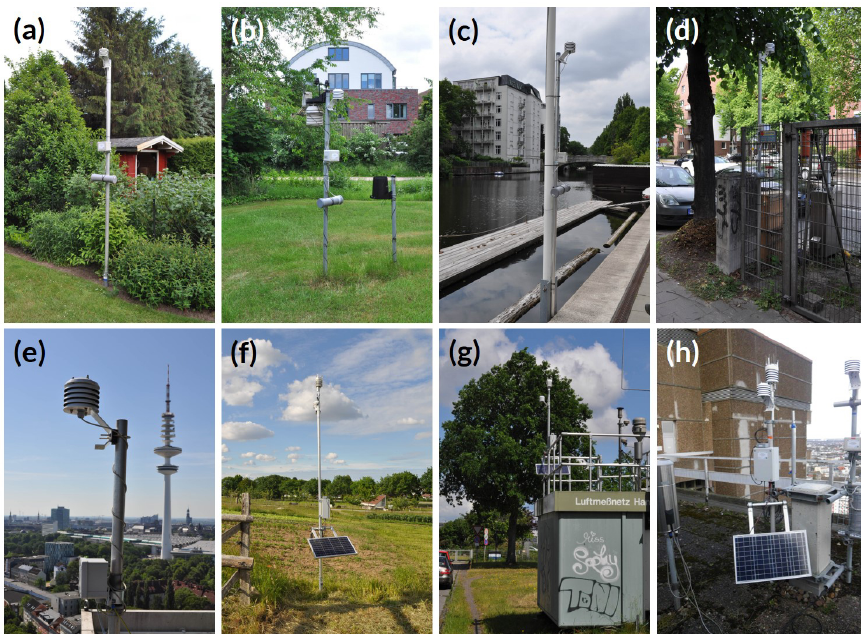
Figure 6. Examples of instrument installations during FESST@HH: APOLLO station (a) as the standard installation in a private garden, (b) attached to an existing weather station on a schoolyard, (c) on a boat landing stage at a channel, (d) on an air quality observation site at a public road, (e) on the balcony of the building of the Meteorological Institute, and WXT weather station (f) as the standard installation on an agricultural field, (g) on top of a container, and (h) on the roof-deck of the building of the Meteorological